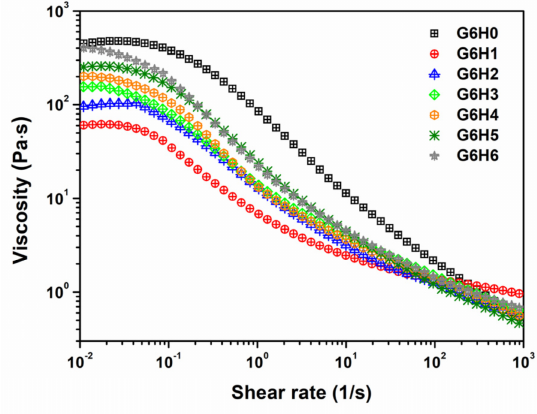
Figure 4. Variation of viscosity as a function of shear rate for the GA/HPMC mixed systems at 25 ◦